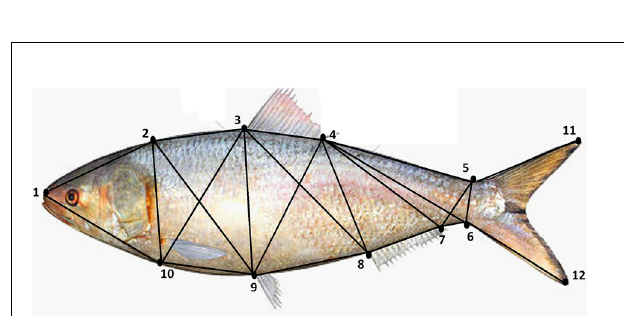
FIGURE 2 | Location of the landmarks used for the morphometric shape analysis of Hilsa shad Tenualosa ilisha . In the study, 12 landmark points delineating 22 truss morphometric distances were superimposed on the body for shape